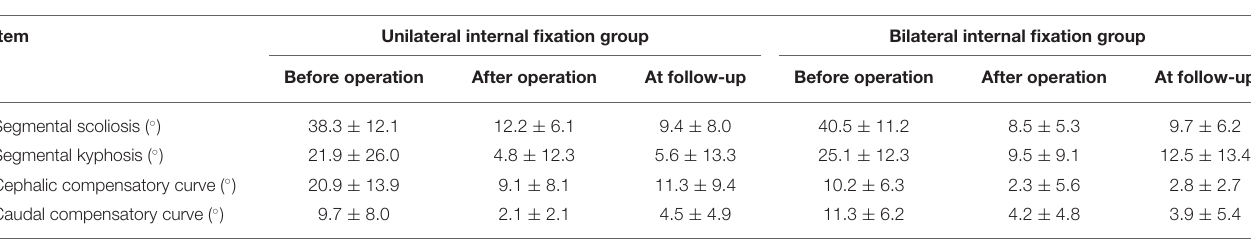
TABLE 3 | Comparison of the orthopedic effects between two groups. Item